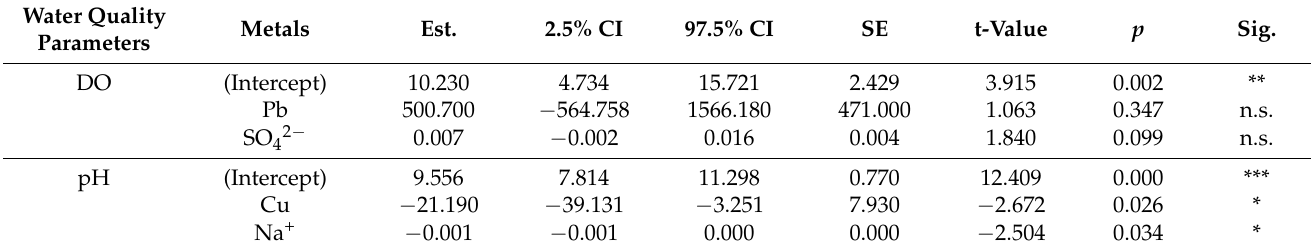
Table 4. Generalized linear model (GLM) testing the effects of toxic metals and physiochemical parameter on the variation of irrigation water quality indices. Model parameters were selected using the ‘backward/forward’ stepwise procedure based on the Akaike information criterion (AIC).